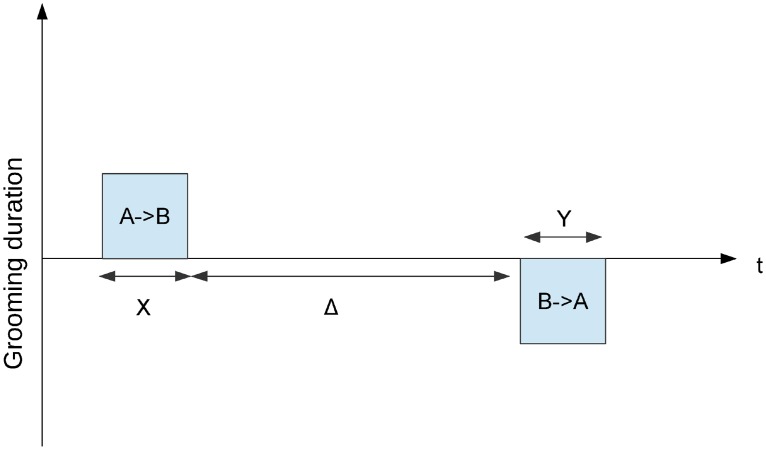
The model used for the longitudinal regression analysis.Consecutive or simultaneous pairs of grooming events between any given dyad {A, B} are represented in our dataset by triples (X, Y, Δ), where: X represents the time that A spent grooming B; Y represents the time that B spent grooming A and Δ represents the time that elapsed between (i) A finishing grooming B, and (ii) B starting to groom A. Within-bout grooming is recorded using negative values of Δ.